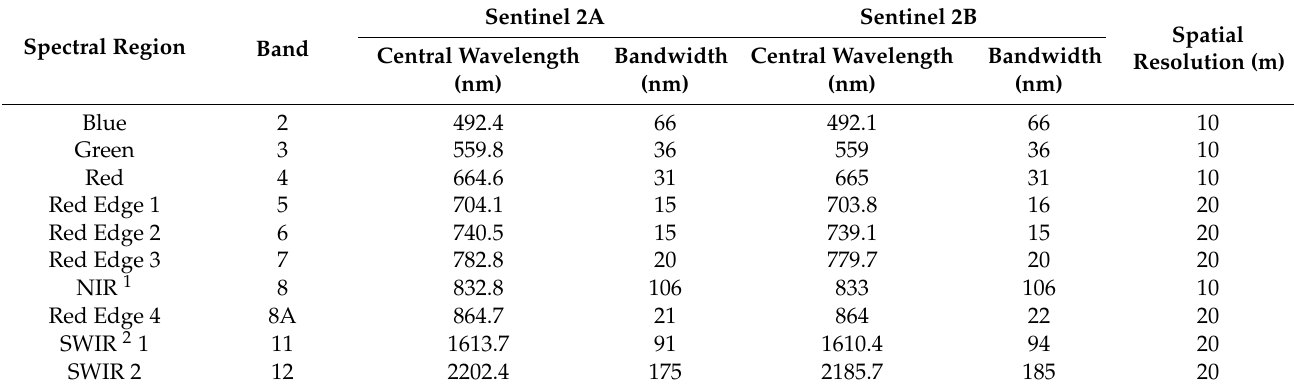
Table 3. Bands of Sentinel 2A and Sentinel